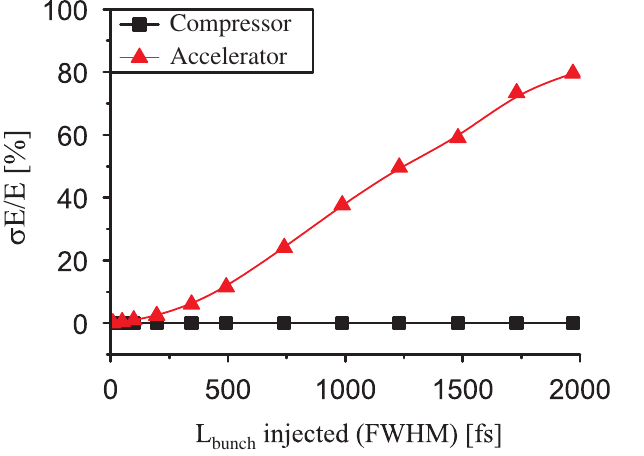
FIG. 10. Effect of the initial energy spread of injected elec- trons on the length of the compressed bunch.